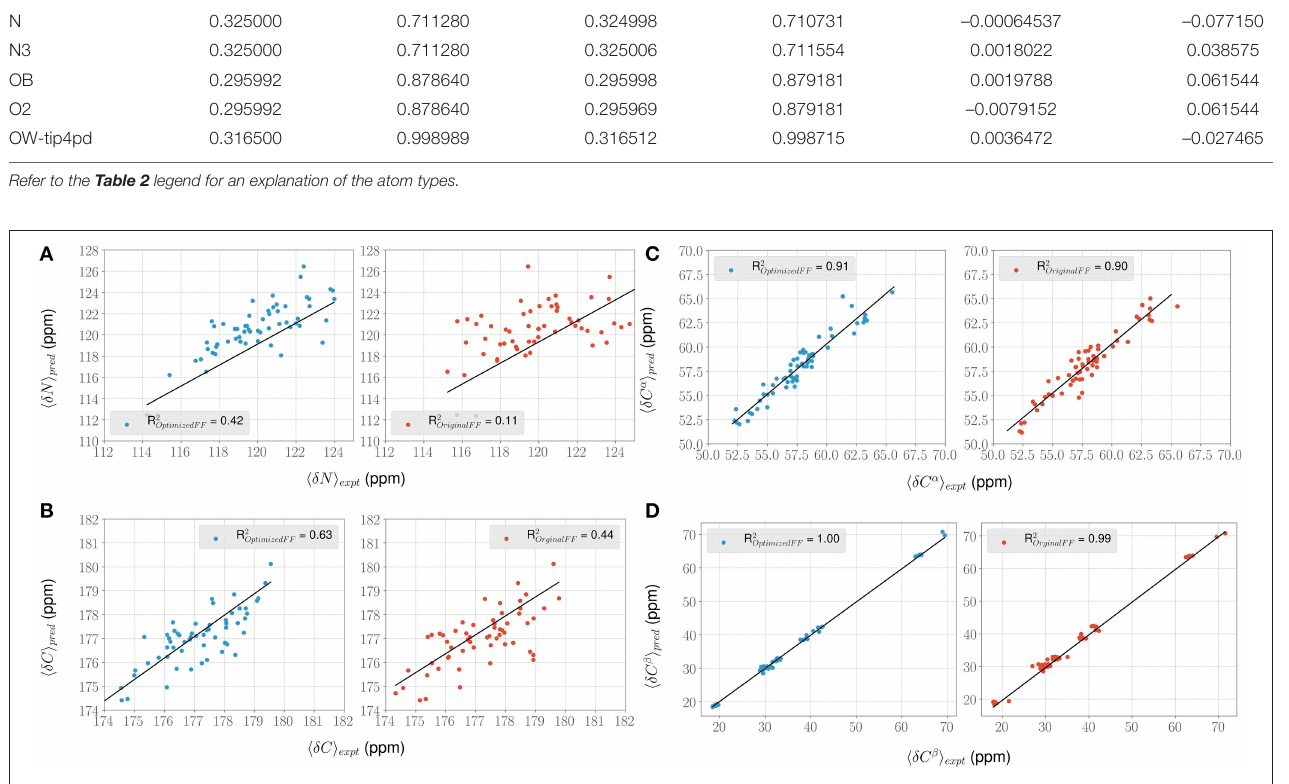
FIGURE 5 | ForceBalance-SAS improves agreement with NMR chemical shift observables for the PaaA2 ensemble. (A–D) Panels highlight the comparison between the average experimental (x-axis) chemical shift vs. predicted (y-axis) chemical shift values for N, C α , C, and C β atoms, respectively. Predictions from the optimized FF (blue dots) are compared with the original FF (red dots) simulations along with the R 2 value for the fits (shown as black lines). Error bars are not highlighted for clarity.